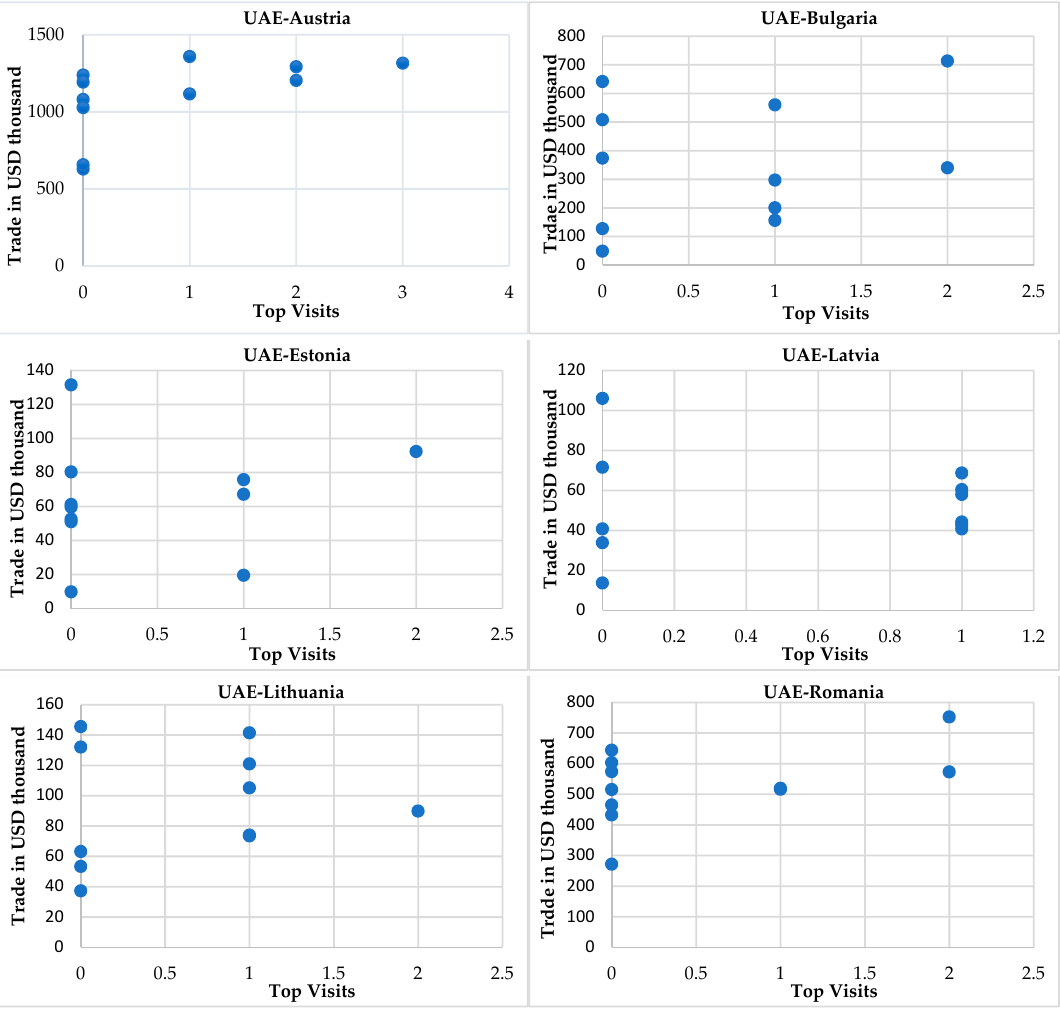
Figure 4. A correlation between the